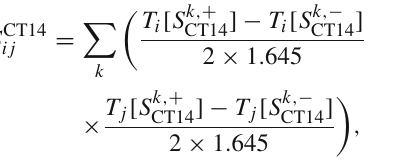
Fig. 2 Theexperimental(excludingoverallnormalizationuncertainty) and theoretical free-proton-PDF covariance matrices for the p+Pb W ± measurement at 8.16 TeV. Indices i , j follow the same ordering as the data points in Fig. 1, with the indices 1 through 24 corresponding to the W − production and 25 through 48 to W +